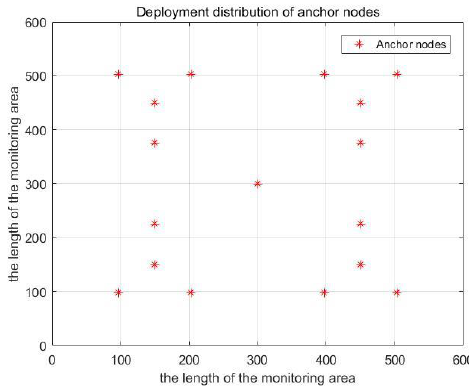
Figure 9. Random distribution of sensor nodes in 3D UWSNs.